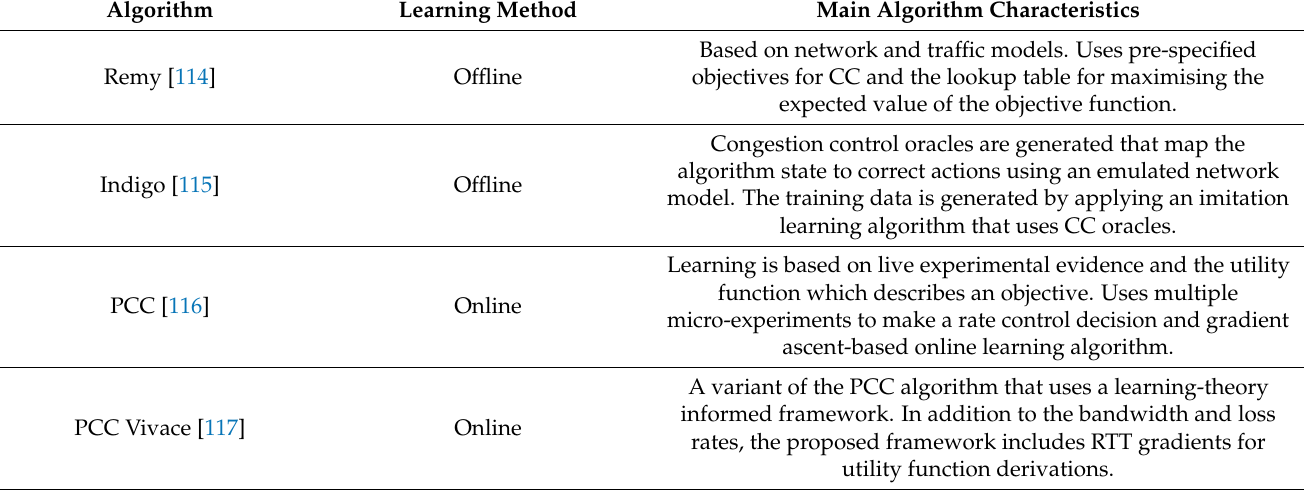
Table 4. Machine learning CC